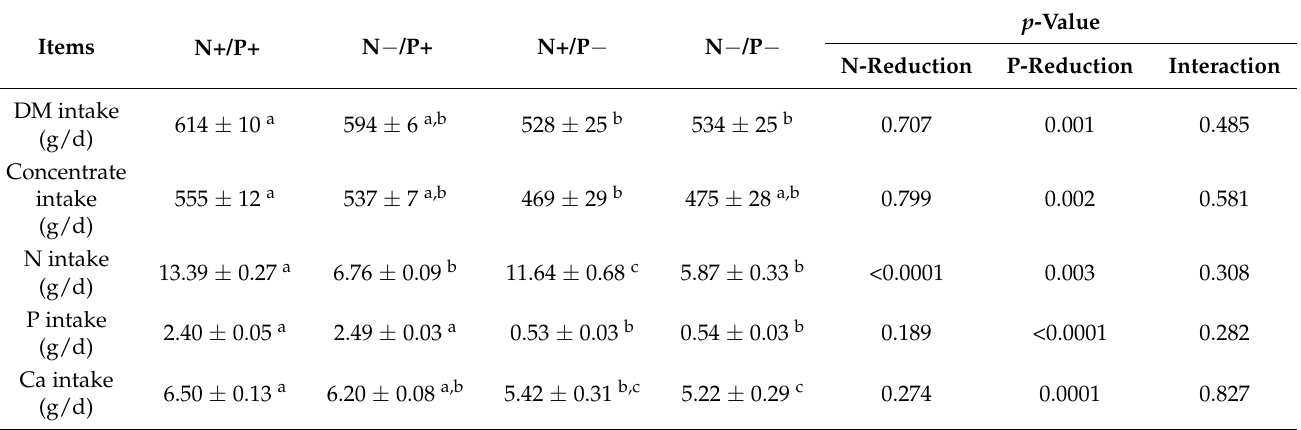
Table 1. Mean daily intakes of DM, concentrate, N, and P of young goats fed an N- and/or P-reduced diet.